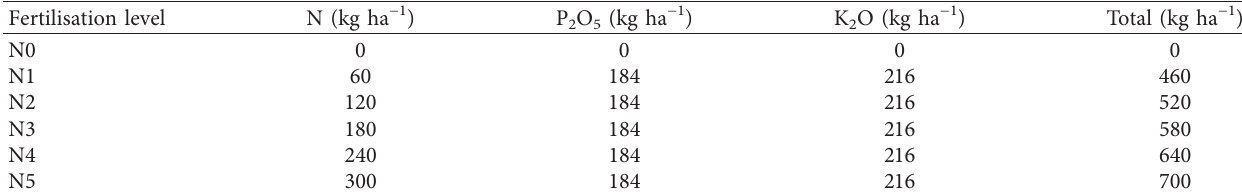
Table 1: NPK fertilisation doses applied in the long-term multifactorial experiment. Fertilisation